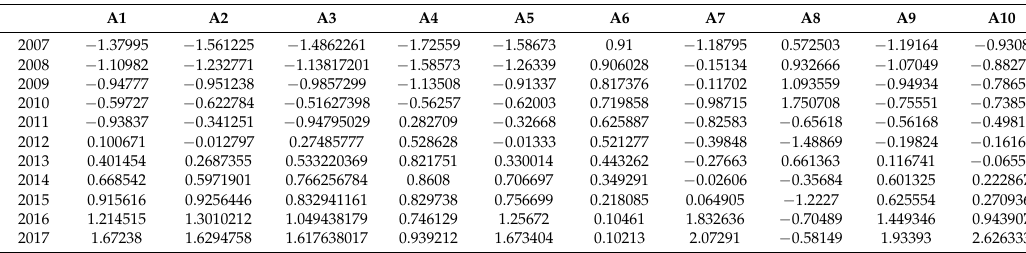
Table 2. Influencing factors after normalization.